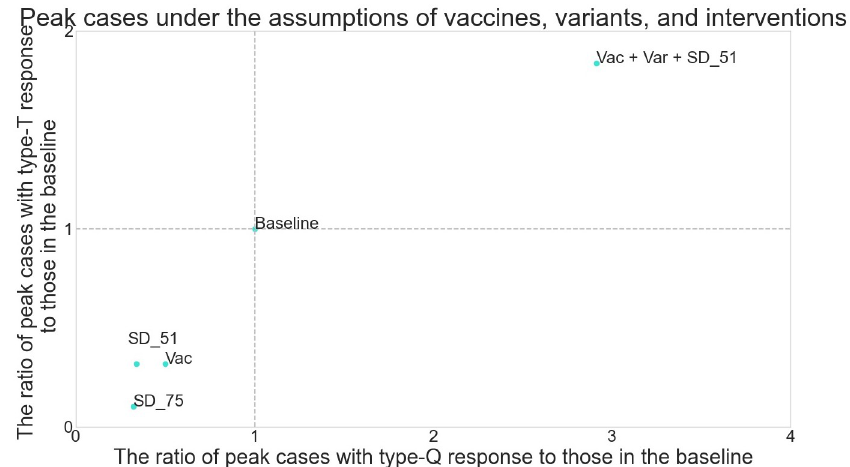
Fig 7. The difference of peak cases considering vaccines, variants, and social distancing.